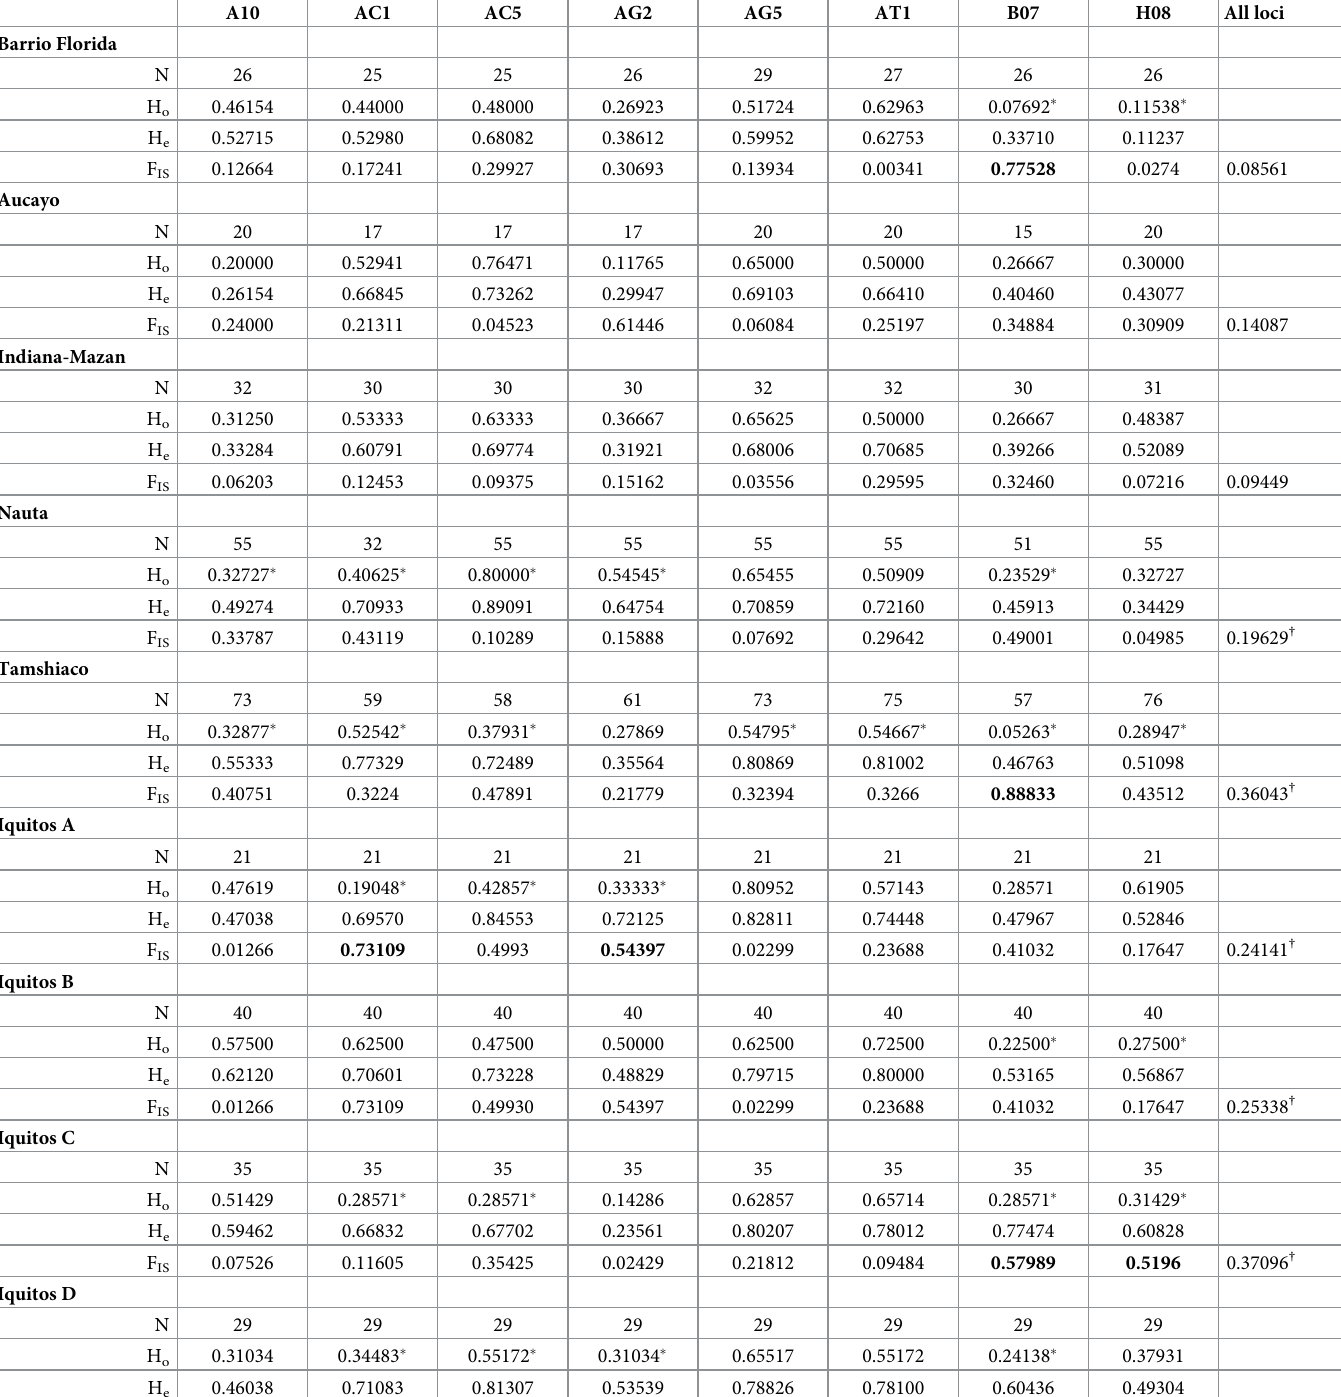
Table 2. Summary of variation at 8 microsatellite loci by sampling